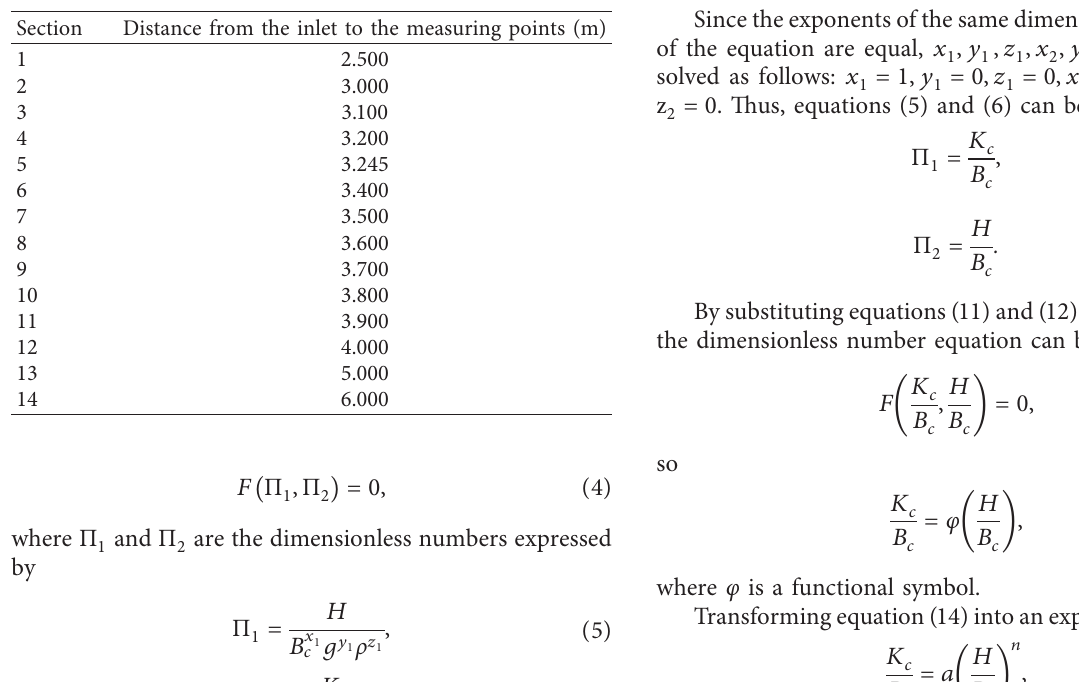
Table 2: Locations of the typical cross-section of the flume for water depth at the centerline of the